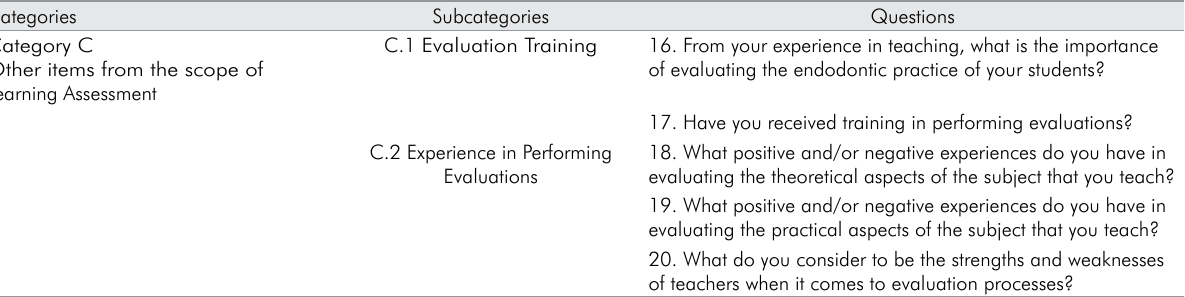
Table 3. Example of Instrument: Questions made by the Interviewer to teachers in Category C.